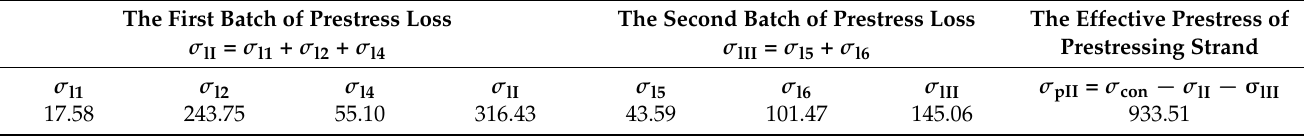
Table 4. The effective prestress of the prestressed concrete beam (unit: